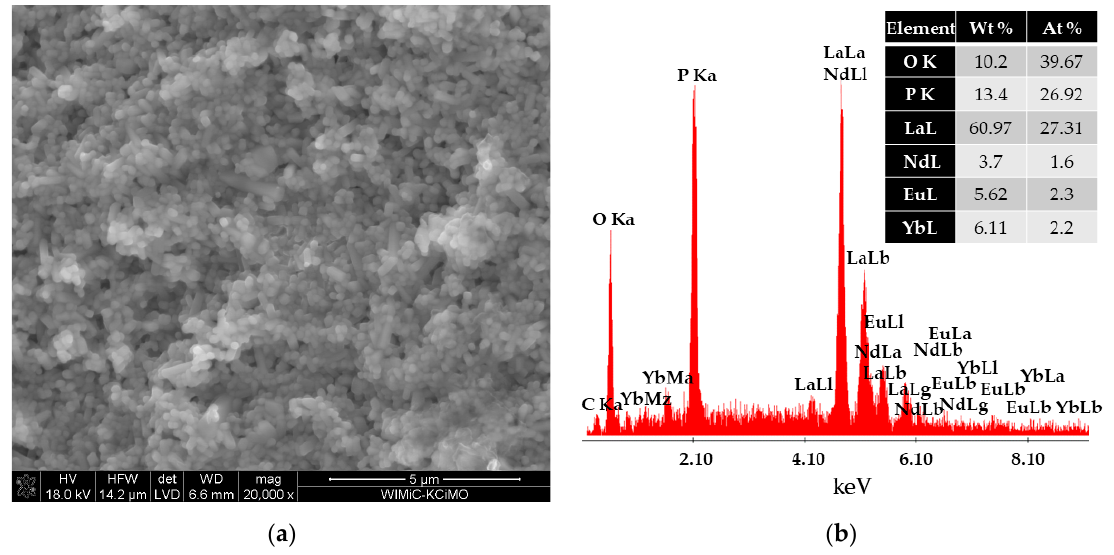
Figure 2. SEM image of LaPO 4 :Eu 3+ /Nd 3+ with magnification 20,000× ( a ) and analysis of the chemical composition of the LaPO 4 :Eu 3+ /Nd 3+ sample ( b ).